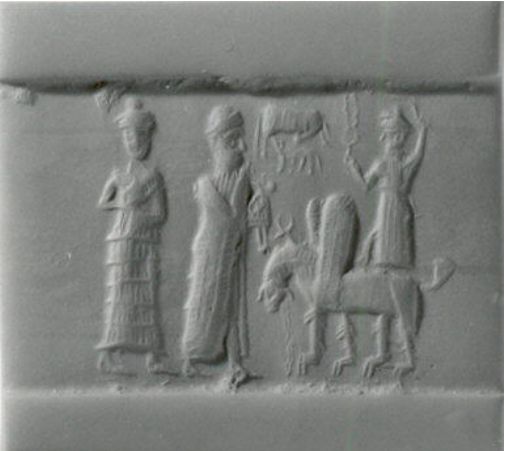
Figure 21. Old Babylonian cylinder seal with storm god on a lion dragon holding a forked lightning and a cow-suckling-calf. CC Metropolitan Museum of Art